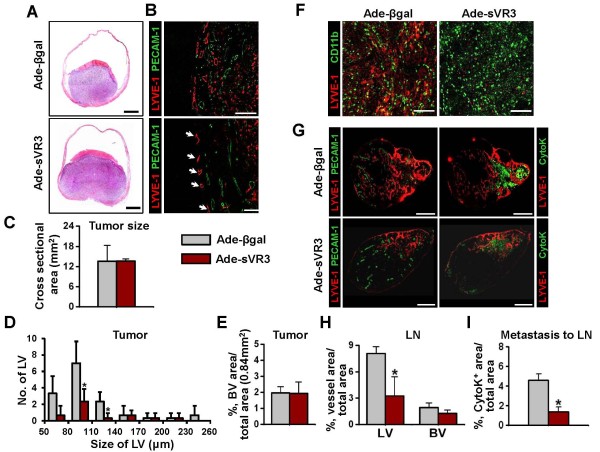
Blockade of VEGF-C/D-VEGFR-3 signaling suppresses profound lymphangiogenesis and lymphatic metastasis, but not recruitment of CD11b+/CD68+ TAM. 1 × 106 MBT-2 cells were injected into the urinary bladders of 8-10-week old female C3H mice. At the day of and two weeks after the tumor cell injection, 1 × 109 pfu Ade-βgal or Ade-sVR3 were injected intravenously to the OUBC mice. 4 weeks after the tumor cell injection, the bladder and the SLN were sampled. (A) Images showing H&E stained sections of tumors. Scale bars, 2 mm. (B) Comparison of cross-sectional area of tumors. Graph shows mean ± SD; n = 5 for each group. (C) Images showing LYVE-1+ LVs and PECAM-1+ BVs in tumors. Scale bars, 200 μm. (D) Comparison of LV numbers at different sizes of LV in the tumor sections. Graph shows mean ± SD; n = 5 for each group. *p < 0.05 versus Ade-βgal. (E) Comparison of BVD per total sectioned area of tumors. Graph shows mean ± SD; n = 5 for each group. (F) Images showing CD11b+ TAM and LYVE-1+ cells. Scale bars, 200 μm. (G) Left panel; images showing LYVE-1+ LVs and PECAM-1+ BVs in LNs. Right panel; images showing LYVE-1+ LVs and CytoK+ metastatic cancer cells in LNs. Scale bars, 500 μm. (H) Comparison of LVD and BVD in LNs. Graph shows mean ± SD; n = 5 for each group. *p < 0.05 versus Ade-βgal. (I) Comparison of densities of CytoK+ metastatic cancer cells in LNs. Graph shows mean ± SD; n = 5 for each group. *p < 0.05 versus Ade-βgal.